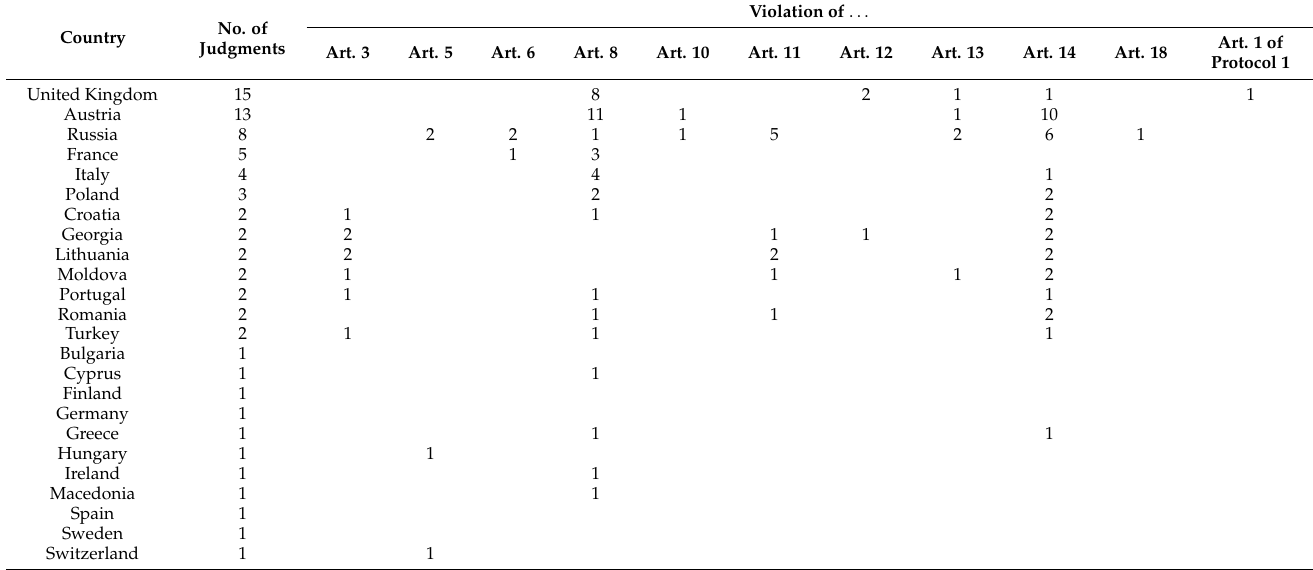
Table 2. Number of identified judgements and violated Articles of the Convention.